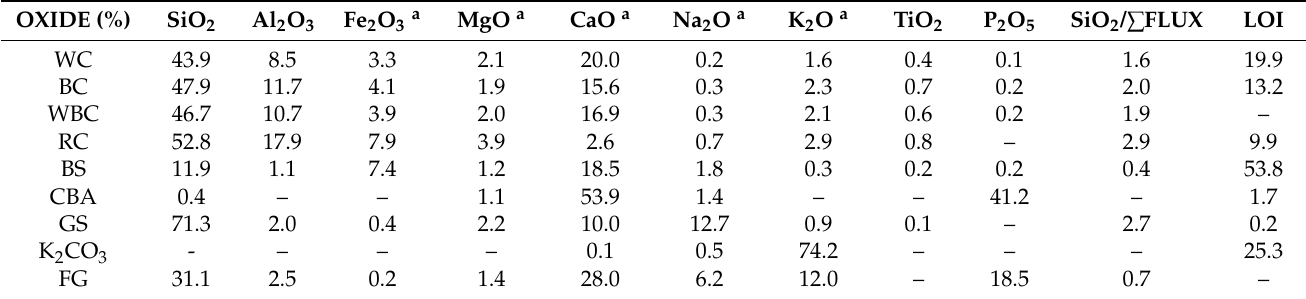
Table 3. Chemical composition ( ∑ Flux = K 2 O + Na 2 O + CaO + MgO + Fe 2 O 3 ) and loss on ignition. OXIDE (%)